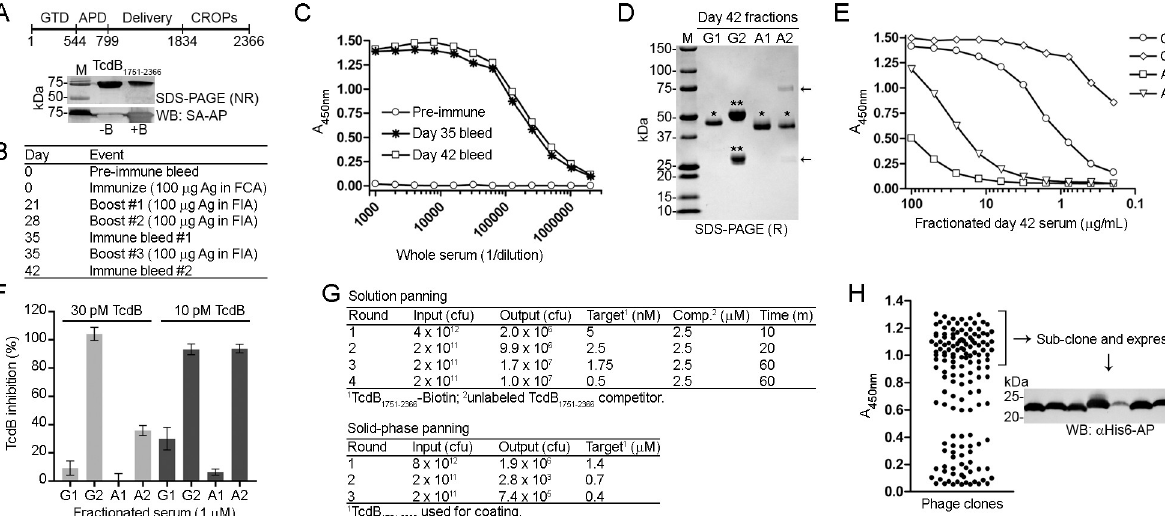
Fig 1. Isolation of high-affinity TcdB-binding V H Hs. (A, top ) Schematic of TcdB. GTD, glucosyltransferase domain; APD, autoprotease domain, Delivery, delivery/receptor binding domain, CROPs, combined repetitive oligopeptides domain. (A, bottom ) A 71.6 kDa fragment of C . difficile toxin B (TcdB 1751-2366 ) was purified, biotinylated and analyzed by non-reducing (NR) SDS-PAGE and Western blot (WB) probed with streptavidin-AP (SA-AP). Approximately 1 μ g of protein was loaded per lane. M, protein molecular weight marker; -B, unlabeled TcdB 1751-2366 ; +B, biotinylated TcdB 1751-2366 . (B) TcdB 1751-2366 was used as an antigen (Ag) for llama immunization with the schedule shown. FCA, Freund’s complete adjuvant; FIA, Freund’s incomplete adjuvant. (C) ELISA showing the binding response from pre-immune and immune llama sera collected on days 35 and 42 post immunization to coated TcdB 1751-2366 . (D) Serum from day 42 post immunization was fractionated using protein G and protein A affinity columns and analyzed by SDS-PAGE under reducing (R) conditions. G1, A1 and A2 fractions contain heavy-chain IgG (hcIgG, � ) while the G2 fraction contains conventional IgG (cIgG, �� ). The arrows denote IgM heavy and light chains in the A2 fraction. (E) ELISA showing the binding response of fractionated day 42 serum to coated TcdB 1751-2366 . (F) Vero cell cytotoxicity assay demonstrating the effect of fractionated day 42 serum on TcdB inhibition, 72 h post addition of TcdB and polyclonal antibodies to Vero cell monolayers. TcdB was used at 10 and 30 pM and polyclonal fractionated sera at 1 μ M. (G, top ) Summary of solution-phase library panning titers using off-rate selection. In each round, the amount of target (biotinylated TcdB 1751-2366 ) was reduced, the amount of competitor (“Comp”; unlabeled TcdB 1751-2366 ) was held constant, and the incubation time of phage + target + competitor was increased. After incubation, the complex of phage and biotinylated TcdB 1751-2366 was captured on streptavidin coated microtiter plates, washed and eluted. (G, bottom ) Summary of solid-phase library panning titers using coated TcdB 1751-2366 . (H) Phage ELISA showing binding of phage displayed V H Hs to coated TcdB 1751-2366 . V H Hs on phage producing the highest ELISA signals were expressed, purified and characterized. The Western blot (WB) shows detection of purified V H Hs with an α -His6-AP secondary antibody.